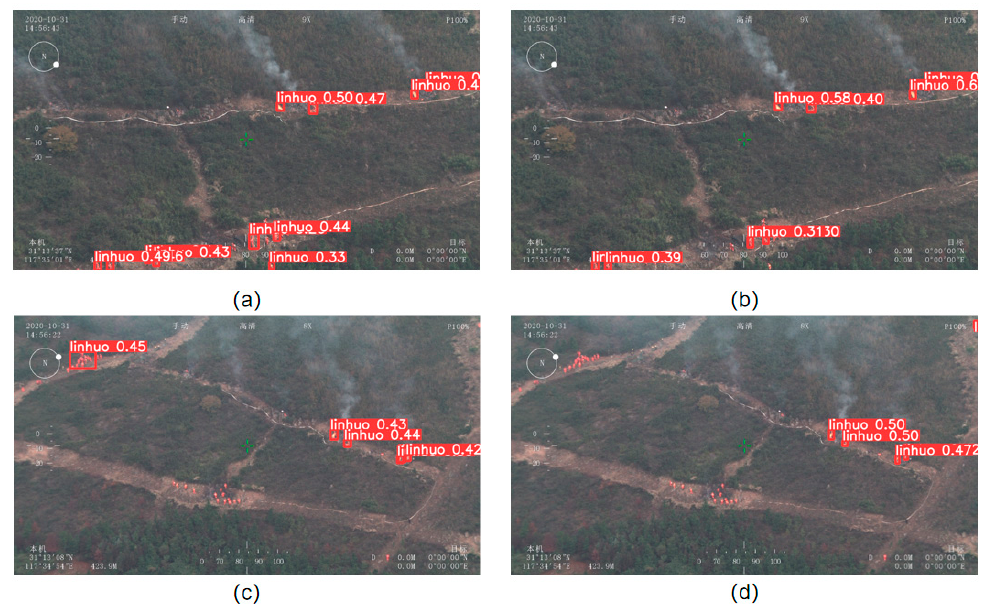
Figure 11. Comparison of YOLOv5s and our detection model. Our small-target forest fire detection model has better performance. ( a ) Four small forest fire targets were detected by YOLOv5s, with seven detection errors. ( b ) Four small forest fire targets were detected by our model, with four detection errors. ( c ) Two small forest fire targets were detected by YOLOv5s, with three detection errors. ( d ) Two small forest fire targets were detected by YOLOv5s, with two detection errors.